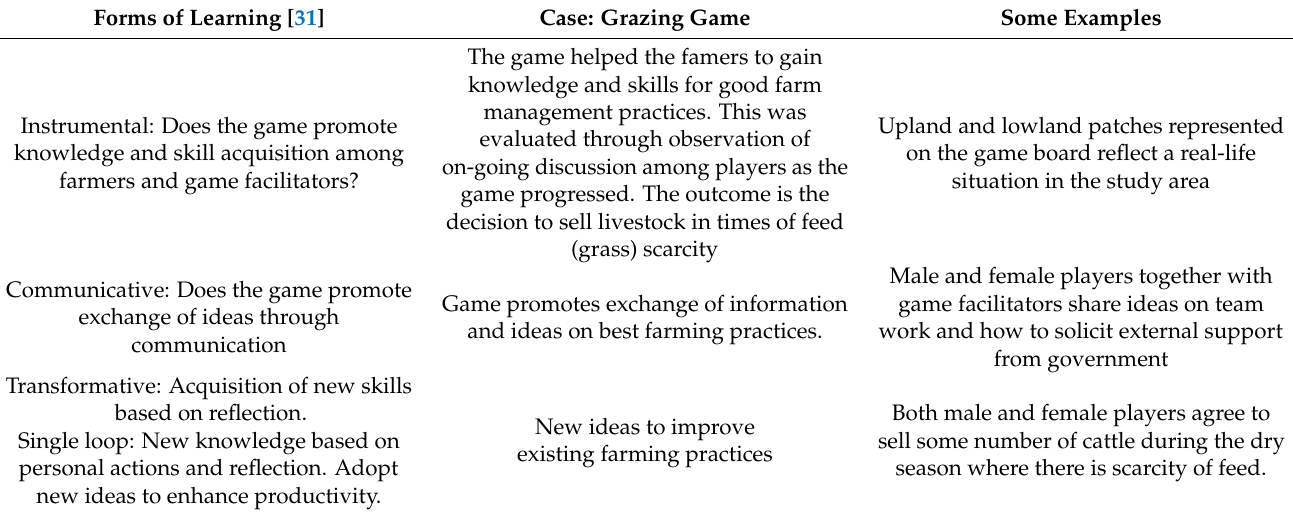
Table 4. Grazing game as a social learning